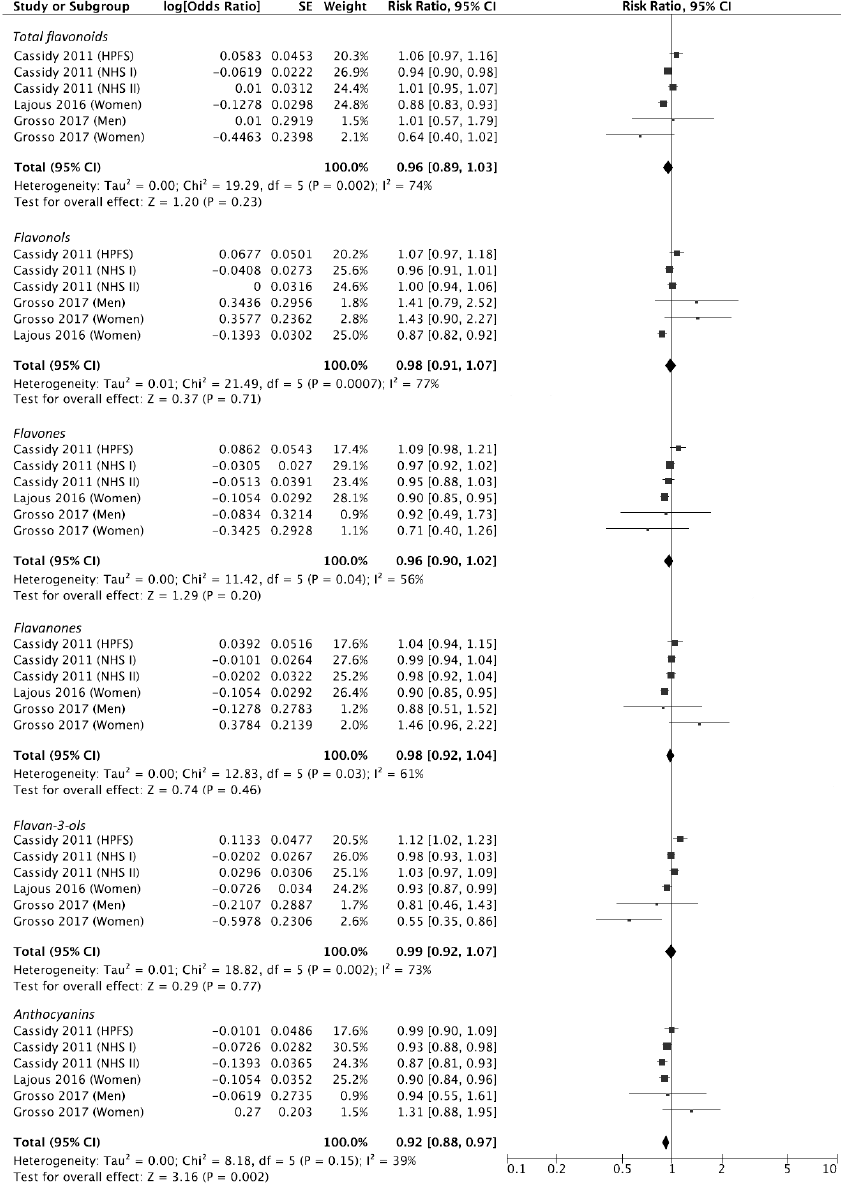
Figure 2. Forest plot of summary relative risks (RRs) of hypertension for the highest versus lowest (reference) category of dietary flavonoid intake.